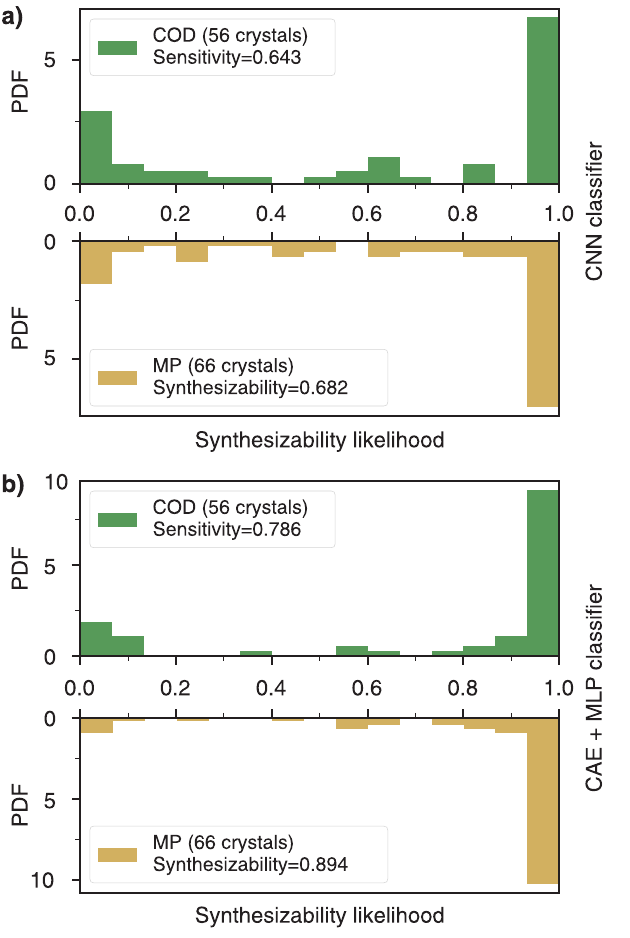
Fig. 6 Synthesizability predictions of the candidate crystalline materials for thermoelectric application. The synthesizability likelihoods evaluated by ( a ) the CNN and ( b ) the CAE + MLP classi fi ers. The total number of thermoelectric crystal samples are 122, from which 56 are collected from the COD and the rest are collected from the Materials Project database. The green and yellow bars show the samples from the COD and those absent in the COD, respectively. Synthesizability refers to the ratio of predicted synthesizable samples to the non-COD crystal samples in our thermoelectric data. The sensitivity is calculated based on the 56 samples that belong to the COD. Table 1 Synthesizability predictions of selected thermoelectric materials.